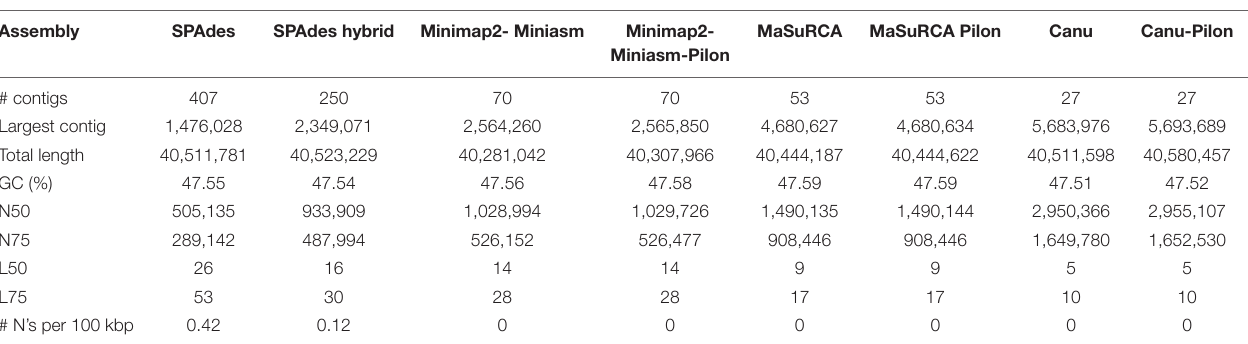
TABLE 2 | Quast assembly